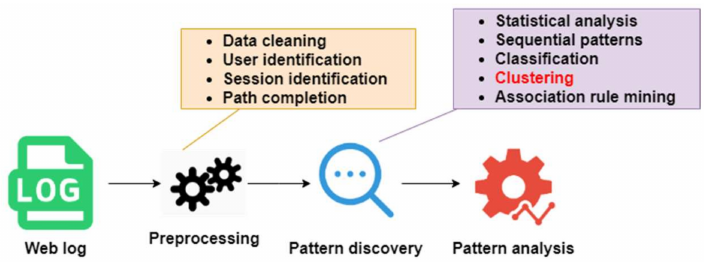
Figure 1. Web usage mining